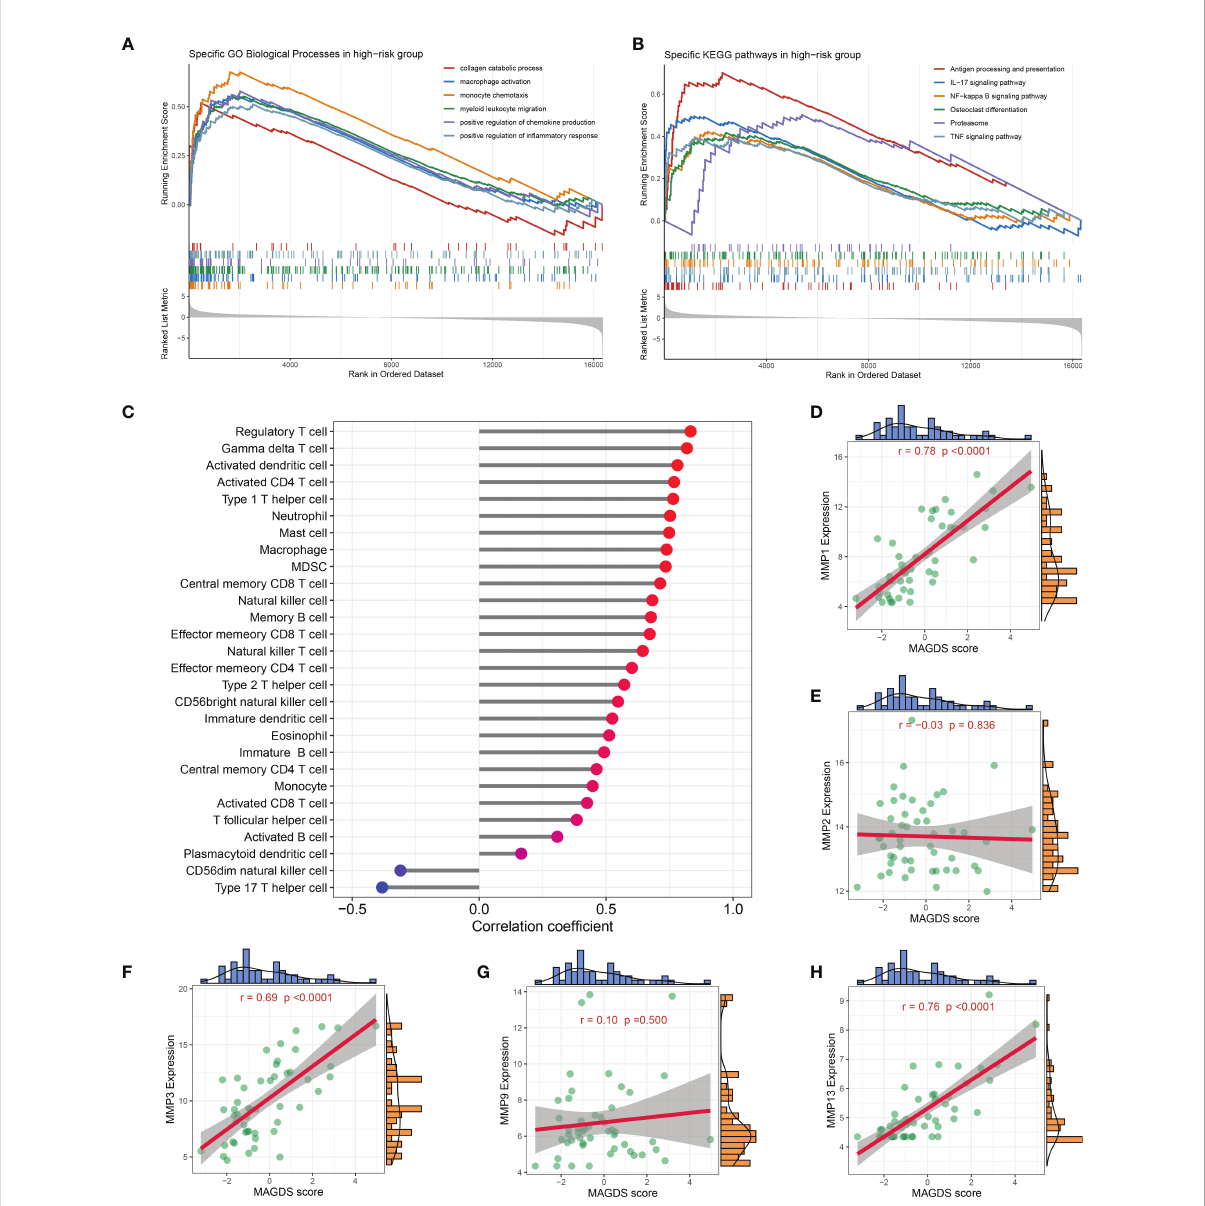
FIGURE 6 Biological signi fi cance underlying MADGS. A-B. GO (A) and KEGG (B) gene set enrichment analysis performed between high- and low-risk groups. (C) Relationship between MAGDS and immune cell abundance. (D-H) . Correlation between MAGDS scores and the expression of MMP1 (D) , MMP2 (E) , MMP3 (F) , MMP9 (G) , and MMP13 (H)